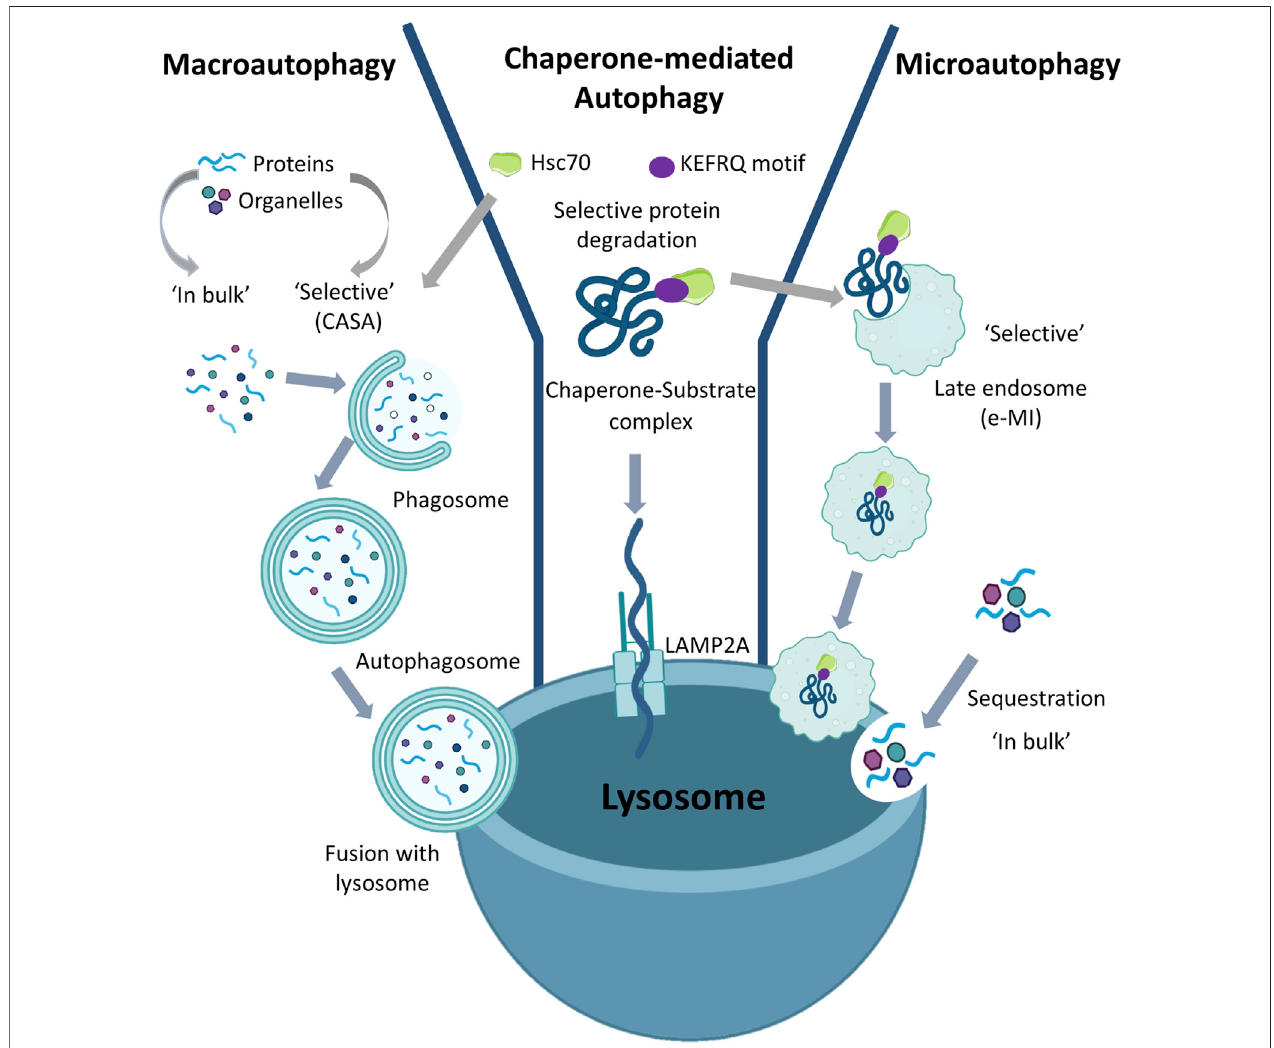
FIGURE 1 | Types of Autophagy: Based on the ways to deliver substrate to the lysosome, autophagy is classi fi ed into macroautophagy, microautophagy, and Chaperone-Mediated Autophagy. Macroautophagy can act either in bulk or selective mode. In both selective (in which there may be involvement of Hsc70) and in bulk, the double membrane autophagosomes sequester the substrate (organelles or cytoplasmic proteins) which is internalized in the lysosomes following the fusion of the autophagosomes with the lysosomal membrane. Chaperone-Mediated Autophagy is always selective as inthis case only proteins containingthe KFERQ motif are recognized by Hsc70 and then transported to the LAMP2A receptor on the lysosomal membrane which allows translocation of the substrate into the lysosome. Microautophagycanalsobeeitherinbulkorselective.Inbulkmicroautophagy,cytosolicproteinsororganellescanbedegraded;inselectivemicroautophagyalsocalled endosomal microautophagy (eMI), the proteins containing the KFERQ